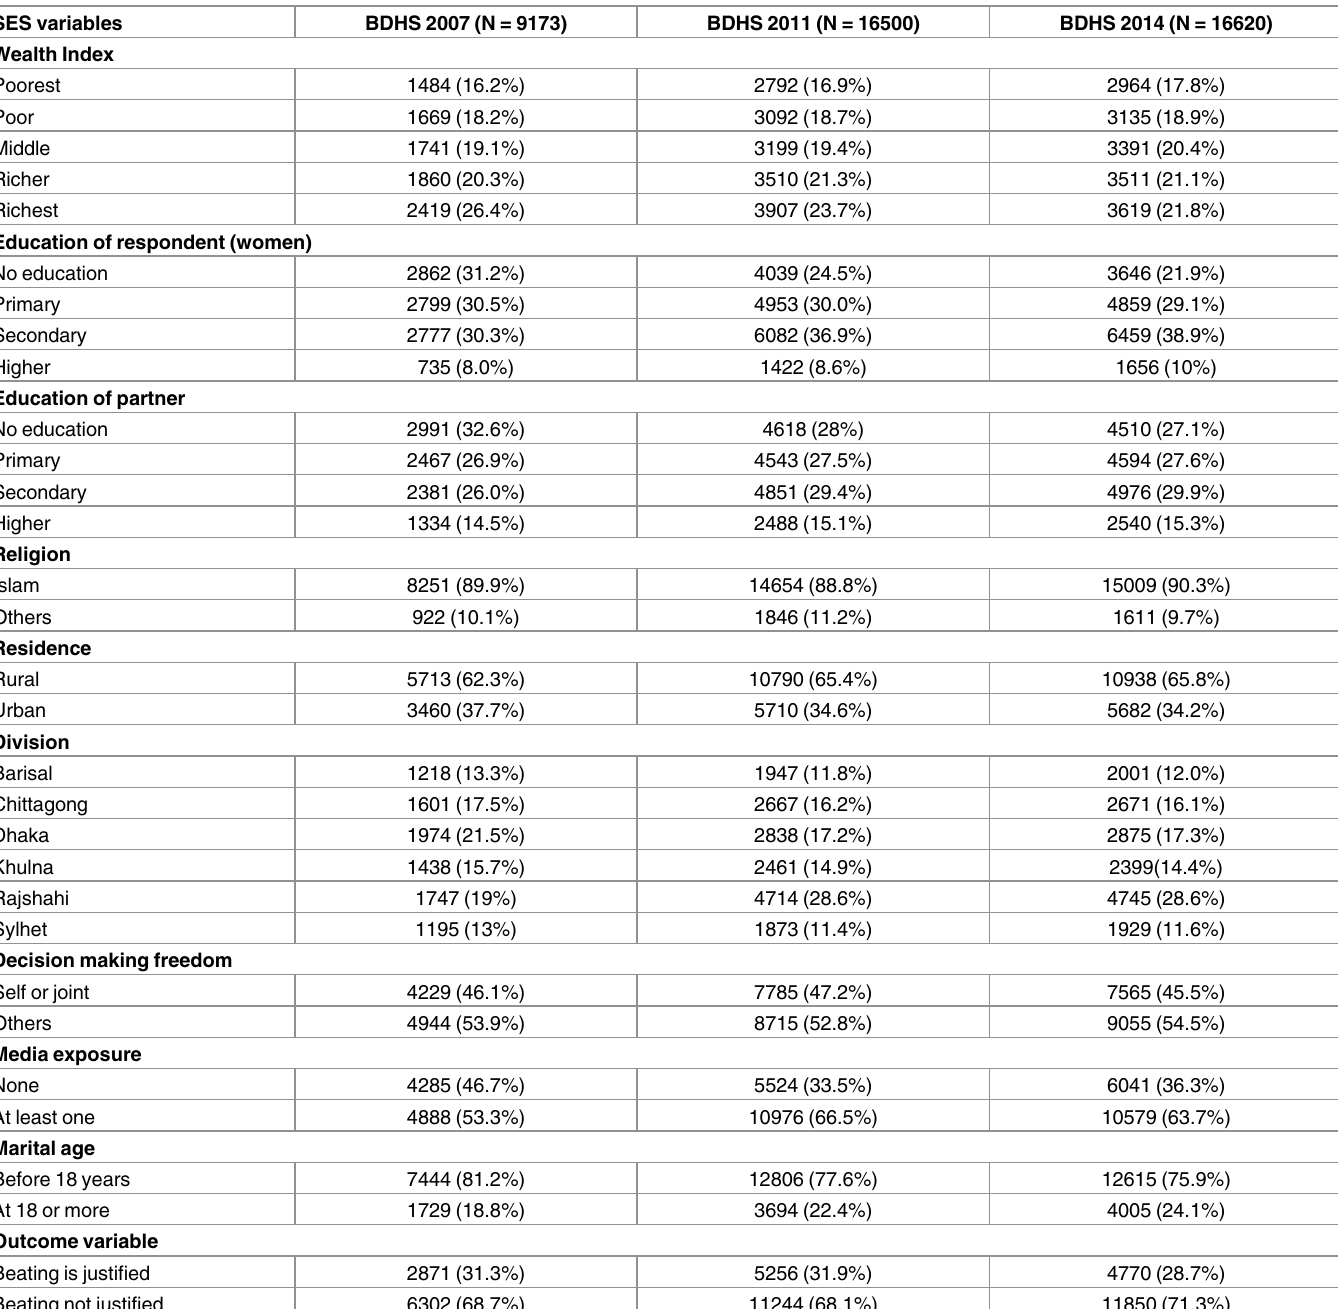
Table 1. Frequency distribution of SES and outcome variable over three